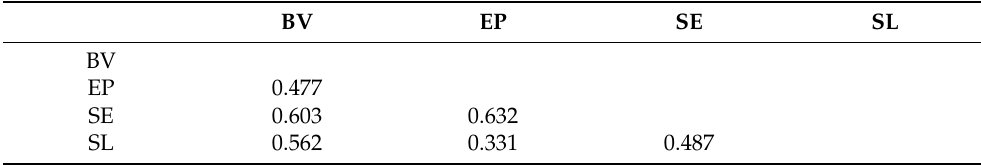
Table 4. Hetrotrait–monotrait ratio